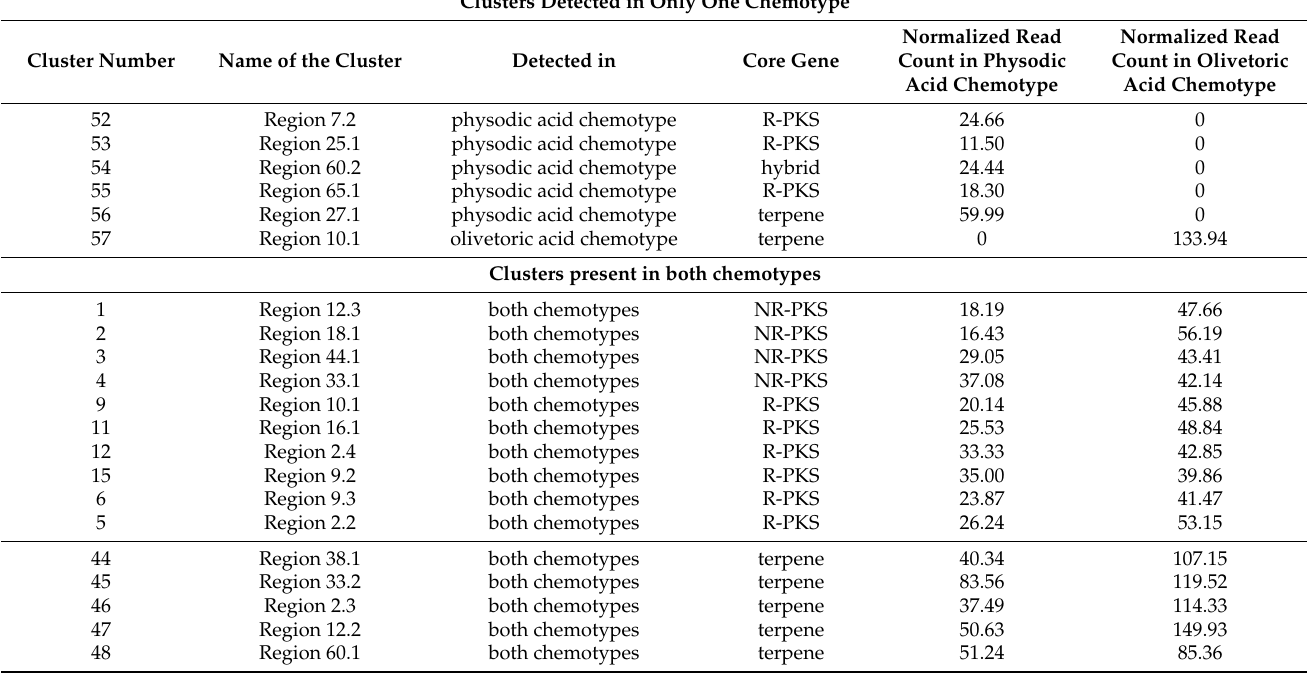
Table 2. Number of raw DNA reads normalized by number of reads and gene length aligned to the core genes of the clusters detected in only one